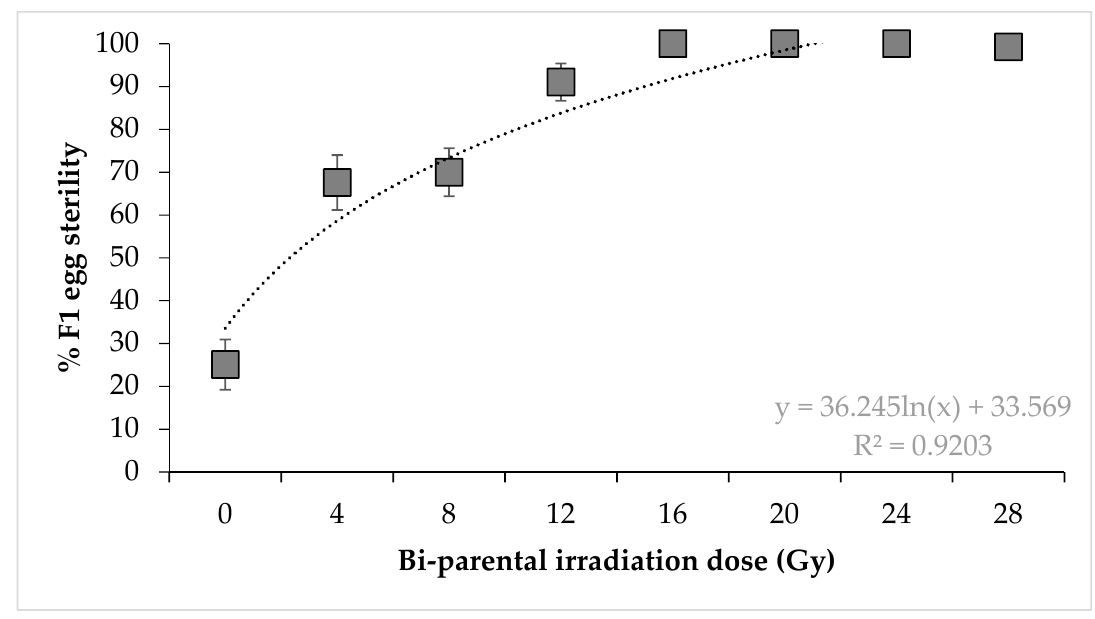
Figure 3. Sterility of Nezara viridula eggs after crosses of irradiated females with irradiated males treated at the same dose. Error bars show standard error (n = 15 crosses per dose).